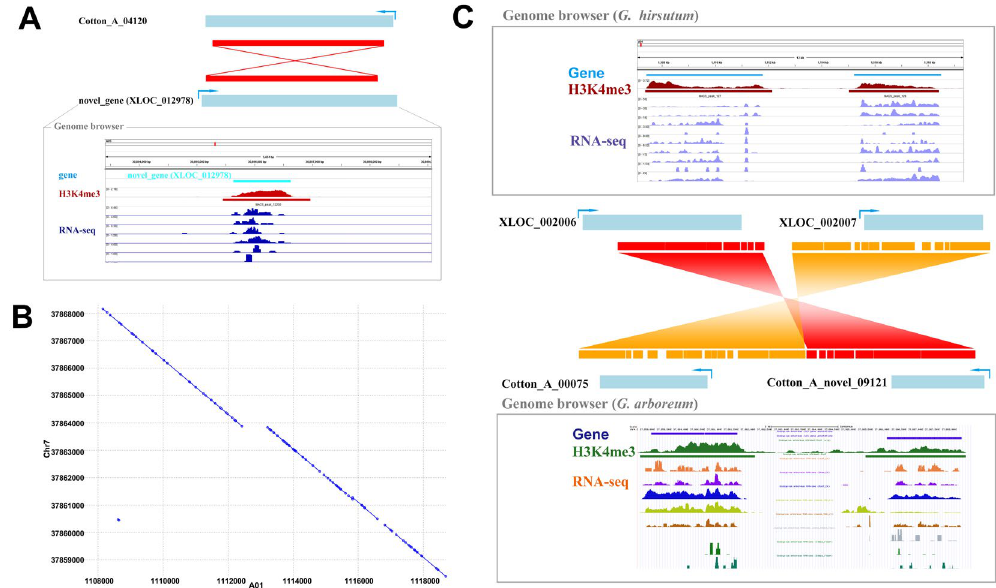
Figure 8. Synteny analysis between G. hirsutum and G. arboretum . ( A ) The Blastn result between the G. arboreum gene Cotton_A_04120 and a novel transcript in G. hirsutum XLOC_012978. The red rectangles indicate alignment regions with high scores. The lower panel presents profiles of H3K4me3 and RNA-seq surrounding XLOC_012978 in SVG software. ( B ) Detail of the reverse synteny regions between chromosome Chr7 (37,868,000 to 37,859,000) in G. arboreum and A01 (1,108,000 to 1,118,000) in G. hirsutum . ( C ) Detail of the known genes and novel transcripts in the ( B ) synteny region. XLOC_002006 and XLOC_002007 are novel transcripts in G. hirsutum . The novel transcript Cotton_A_novel_09121 in G. arboreum shares a reverse collinearity relationship with XLOC_002006. The known gene Cotton_A_00075 in G. arboreum shares a reverse collinearity relationship with